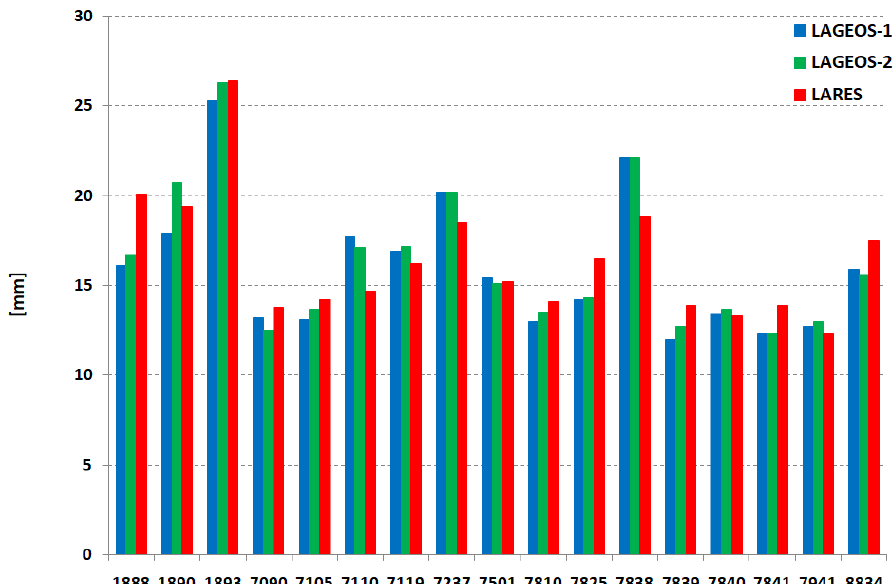
Figure 3. The average orbital RMS per station.